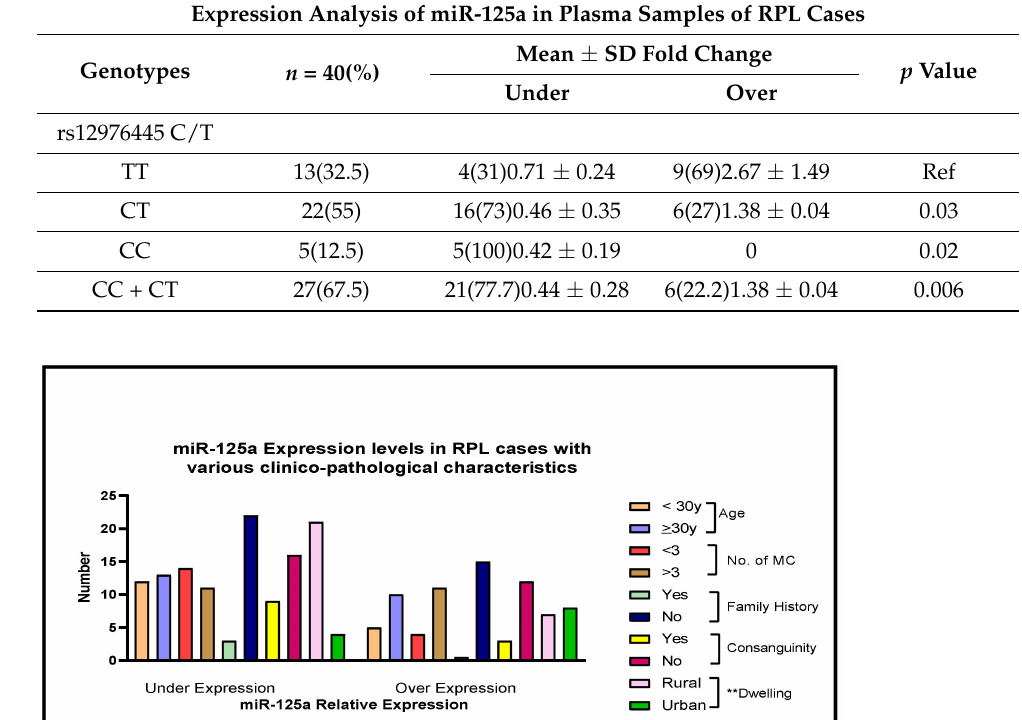
Table 4. miR-125a expression in plasma samples of RPL cases in relation to genotypes.